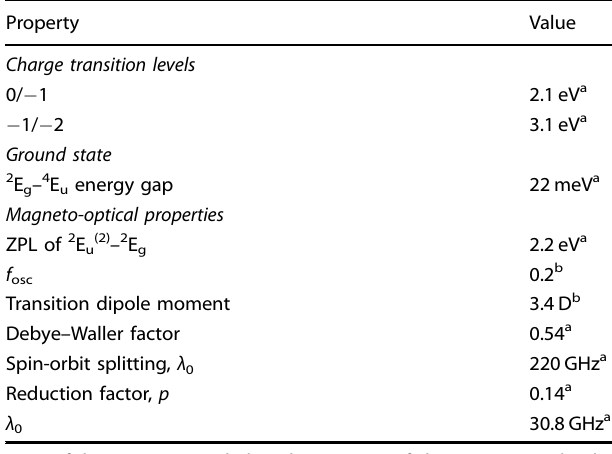
Fig. 3 Optical properties of MgV( − ). a The CASSCF vertical absorption spectra from both ground states of MgV( − ). b A respective state energy diagram as deduced by Δ SCF method using HSE06 functional for the bright electronic transitions. Here, 2 A 1u state is positioned according to the CASSCF energy gap between 2 A u and 2 E u(2) while omitting the structural relaxation. c HSE06 phonon sideband for the 2 E u(2) – 2 E g transition, overlapped with the experimental PL signal from the Mg color center (experimental data is from ref. Table 1. Summary of the major fi nding for the MgV( − )